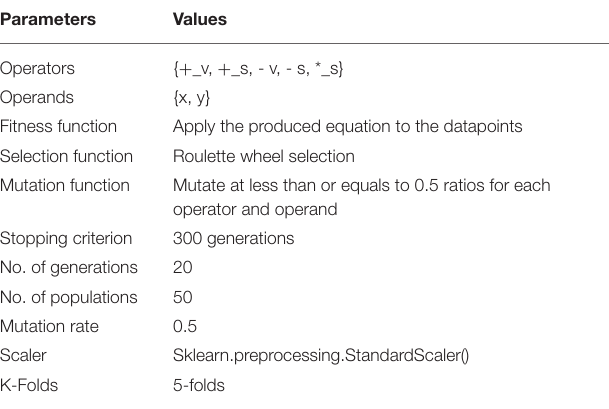
TABLE 1 | A list of parameters and values used in the